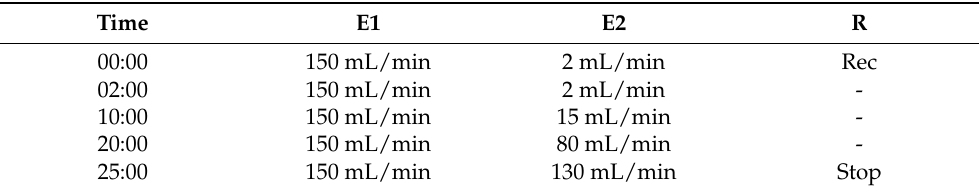
Table 2. The information of velocity of drifting gas (E1), carrier gas (E2), and the recording (R) of the beginning and